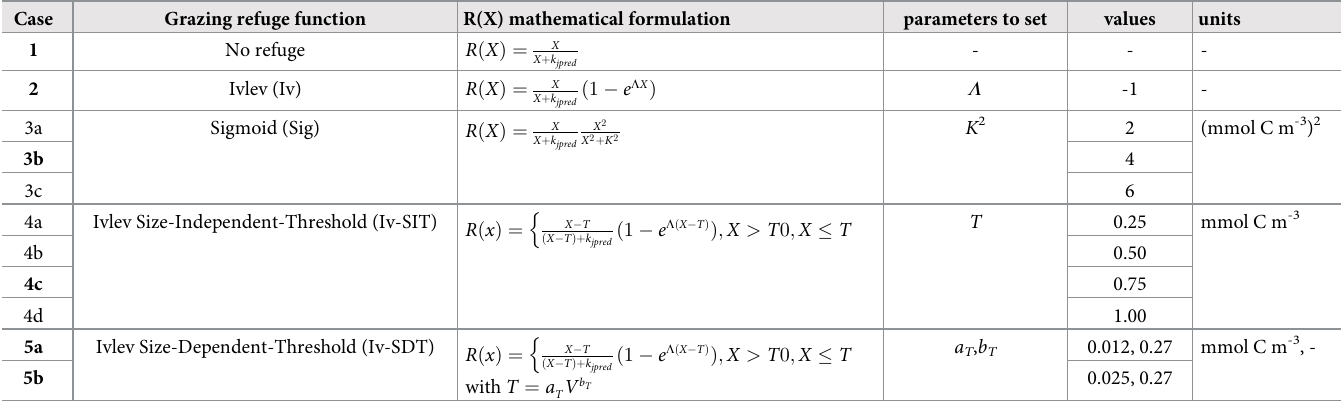
Table 1. Various mathematical formulations of the grazing rate R. Case Grazing refuge